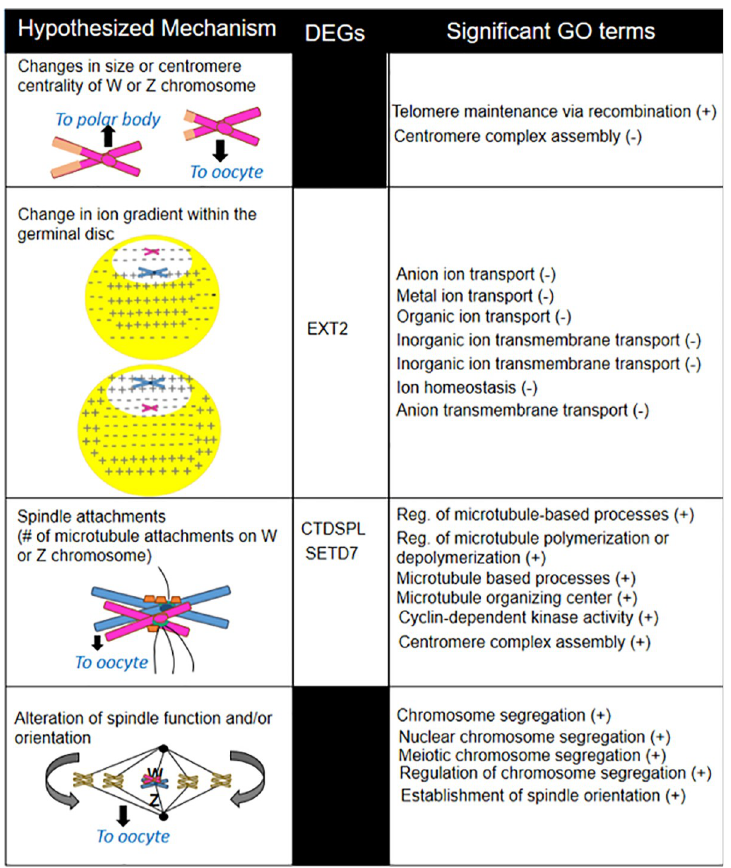
Fig 5. Differentially Expressed Genes (DEGs) (all were downregulated) and significantly enriched GO terms in corticosterone compared to control-treated birds that may function in each of the proposed hypotheses for sex ratio adjustment in birds. Plus and minus signs indicate the direction of the correlation with corticosterone